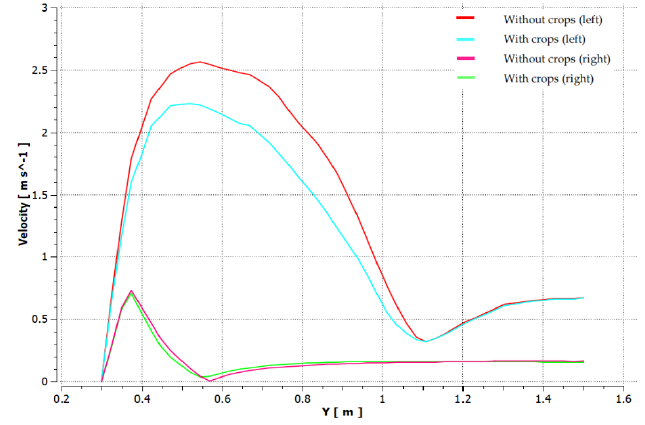
Figure 8. Wind speed curves on both sides of crops.